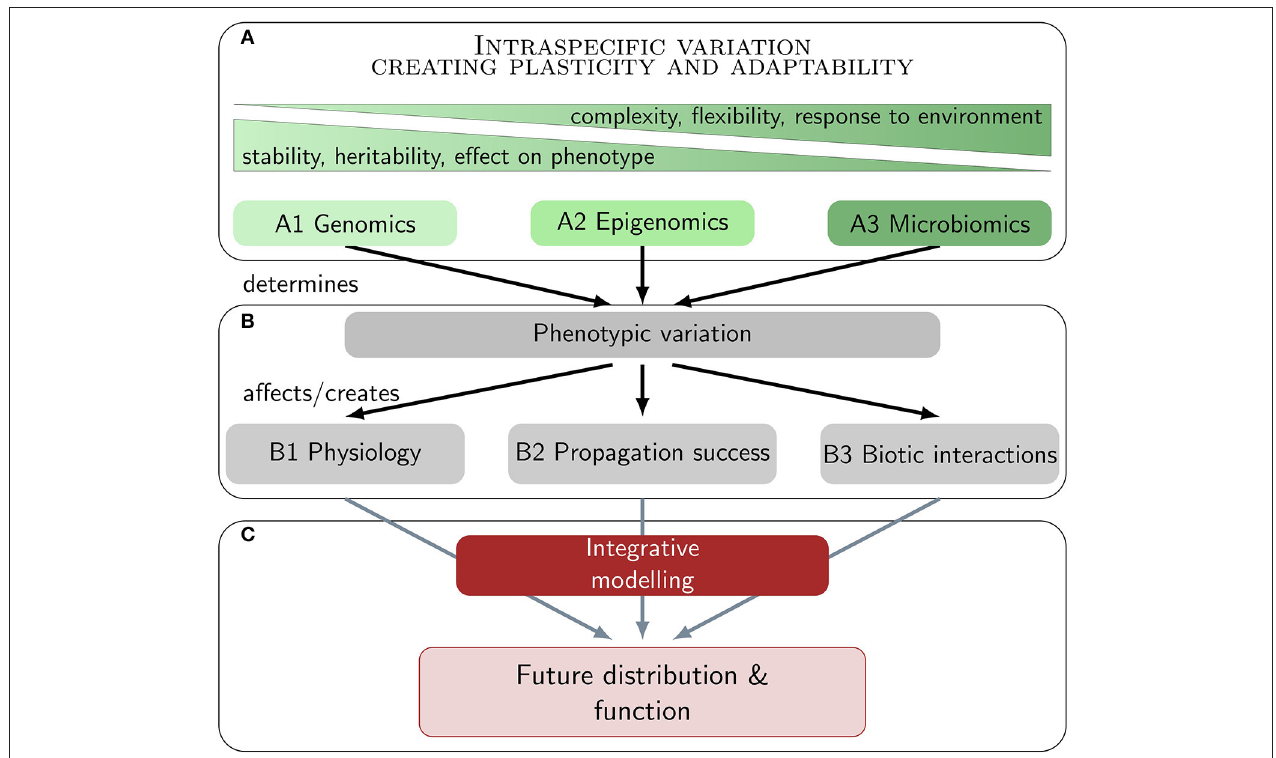
FIGURE 1 | Realistic predictions of future distributions and ecosystem functions of marine macrophytes under climate change rely on multi-disciplinary research. Climate change research should ideally integrate various levels of intraspecific variation and their effect on phenotypic and physiological variation. The ultimate goal is to widen the concept of niche stability in conventional modeling approaches with this multi-layered plasticity